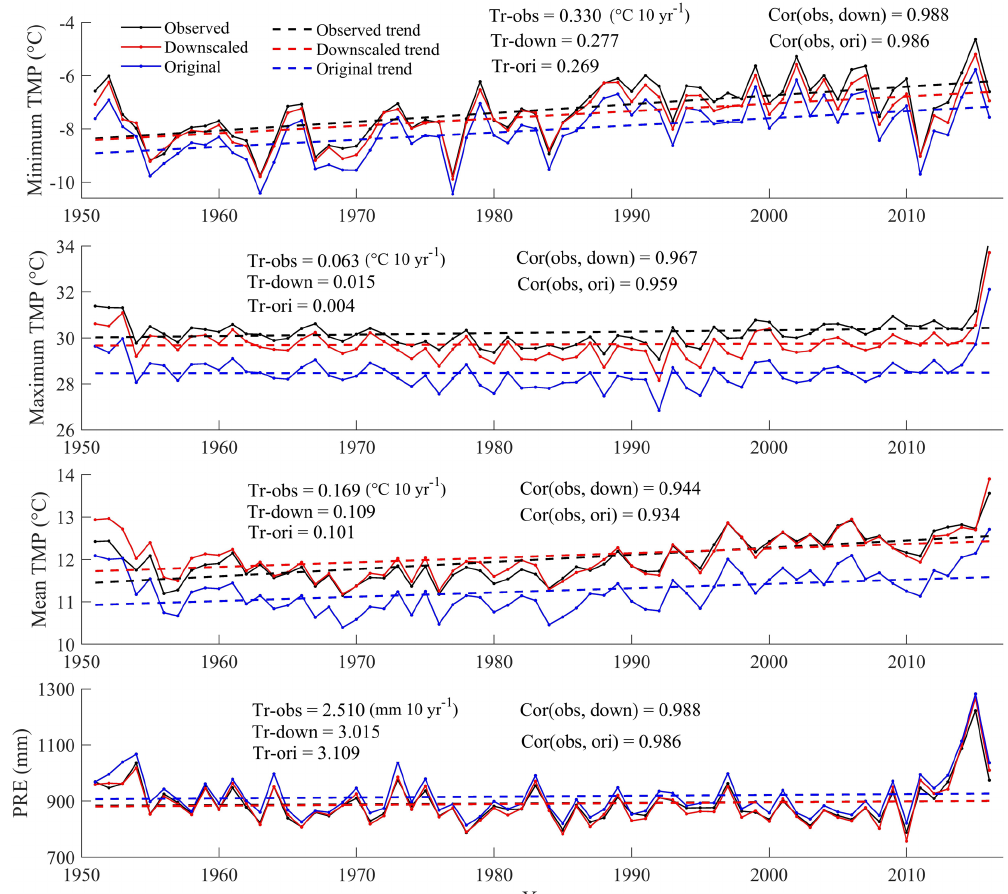
Figure 8. Temporal variations in annual TMPs and PRE over China during 1951–2016 based on the 0.5 (cid:48) downscaled datasets with bilinear interpolation, 30 (cid:48) original datasets, and observed datasets. Tr-obs, Tr-down, and Tr-ori indicate the annual trends calculated using the ob- served, 0.5 (cid:48) downscaled, and 30 (cid:48) original datasets, respectively. Cor(obs, down) indicates the correlation coefficients of the annual values from observed and 0.5 (cid:48) downscaled data, while Cor(obs, ori) indicates the correlation coefficients of the annual values from the observed and 30 (cid:48) original